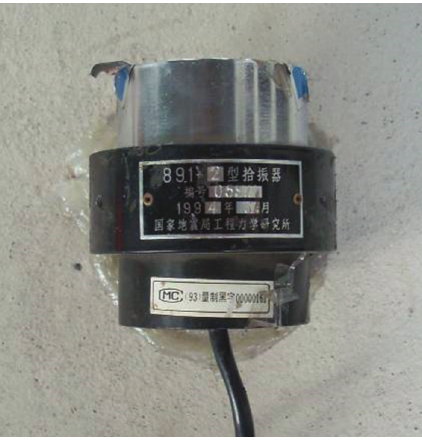
Figure 8: Speed sensor.